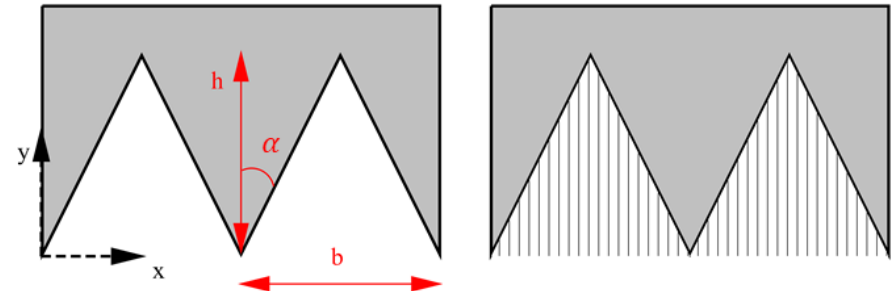
Figure 4. Schematic of the sawtooth and the combed-sawtooth TE geometry